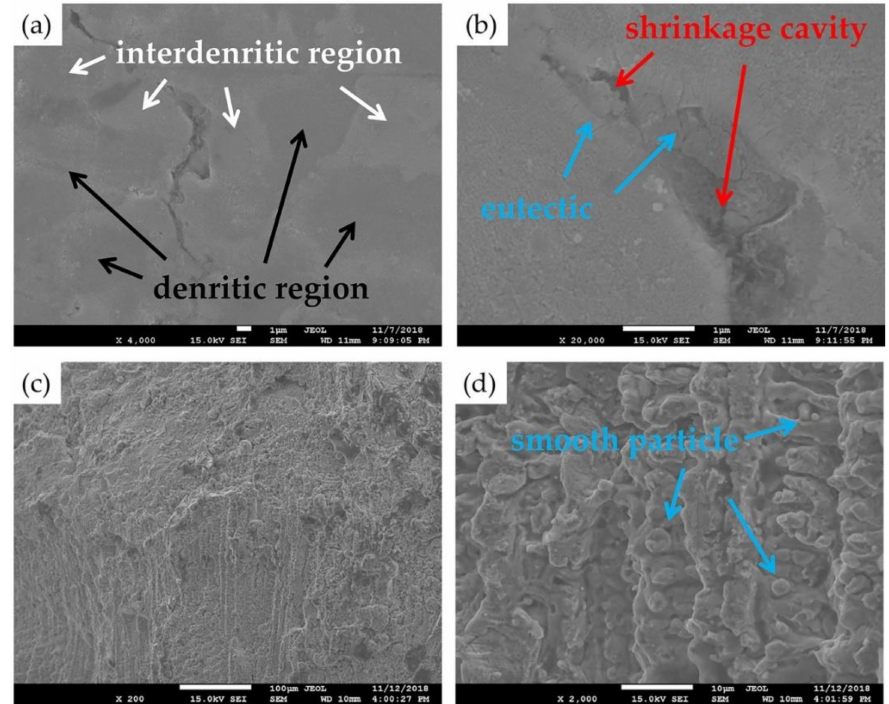
Figure 8. Morphology of ( a , b ) a solidification crack and ( c , d ) its